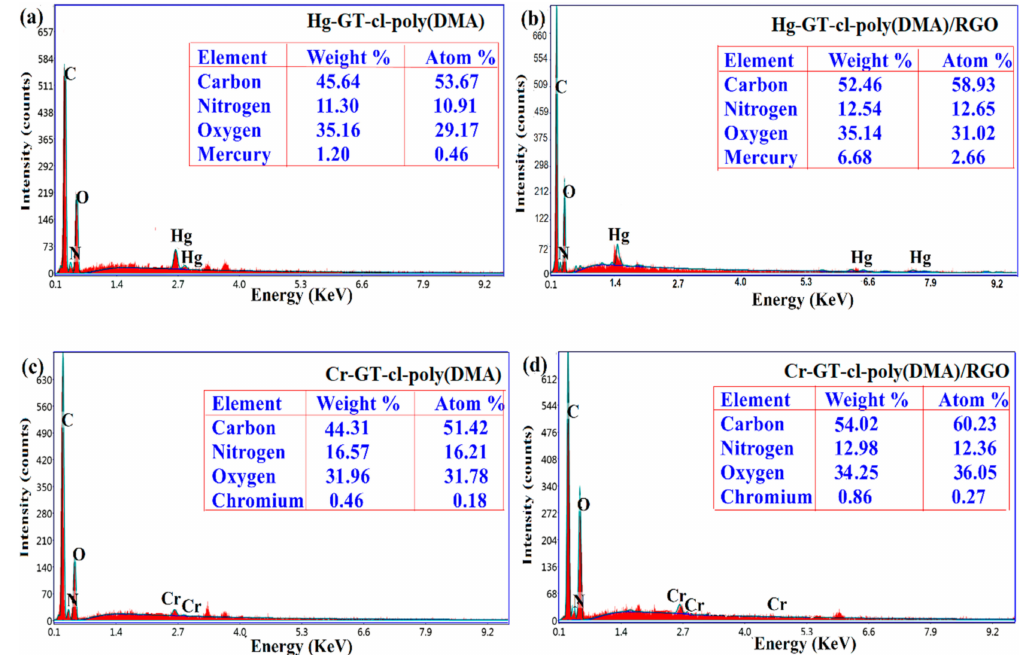
Figure 5. Energy dispersive X-ray spectroscopy and elemental weight percentage for ( a ) Hg 2 + adsorbed gum tragacanth-cl- N,N -dimethylacrylamide (GT-cl-poly(DMA)) hydrogel, ( b ) Hg 2 + adsorbed reduced graphene oxide incorporated gum tragacanth-cl- N,N -dimethylacrylamide (GT-cl-poly(DMA) / RGO) hydrogel composite, ( c ) Cr 6 + adsorbed gum tragacanth-cl- N,N -dimethylacrylamide (GT-cl- poly(DMA)) hydrogel and ( d ) Cr 6 + adsorbed reduced graphene oxide incorporated gum tragacanth-cl- N,N -dimethylacrylamide (GT-cl-poly(DMA) / RGO) hydrogel